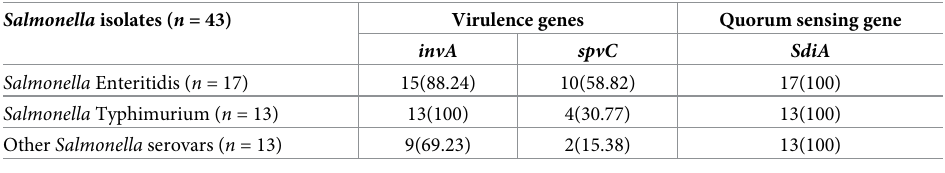
Table 4. Distribution of virulence and quorum sensing